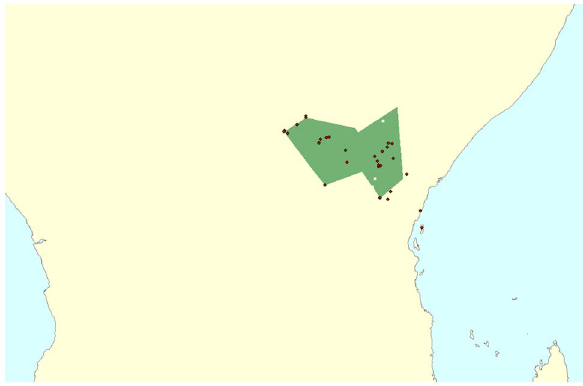
Figure 7. Localities of intermediate forms. Point locality for intermediate forms and imperfect mimics overlain over inferred polygon for subspecies polytrophus and meseres . Female forms plotted are: f. trimeni , f. dorrippoides , f. dionysoides , f. proto- cenea, f. mixtoides , f. swynnertoni , f. carpenter and f. lamborni , and intermediates between f. lamborni and other forms.